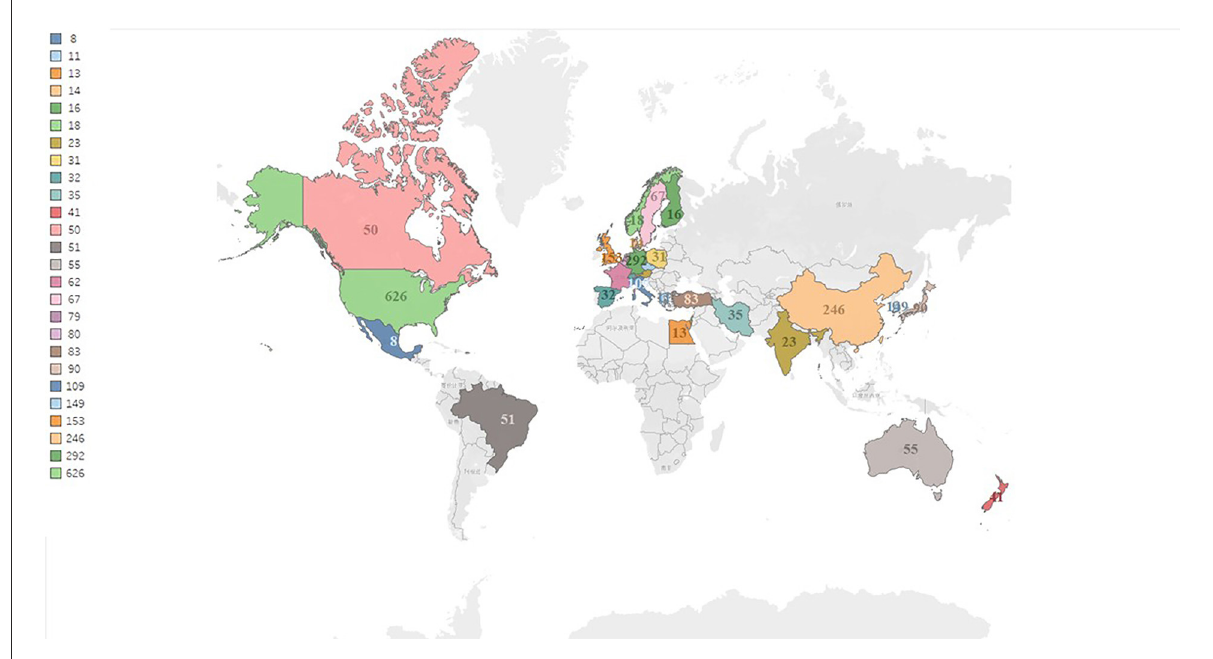
FIGURE4 The global distribution countries on the research of tinnitus treatment.